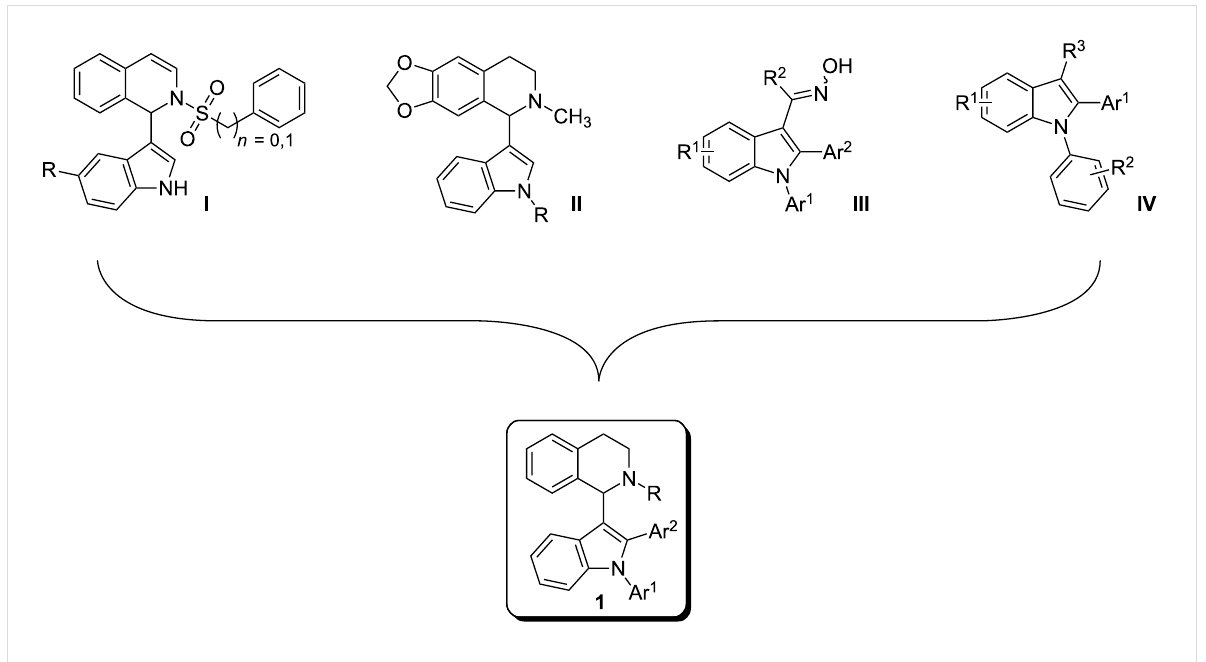
Figure 1: General structures of biologically active dihydroisoquinolines, THIQs and 1,2-diarylindoles.